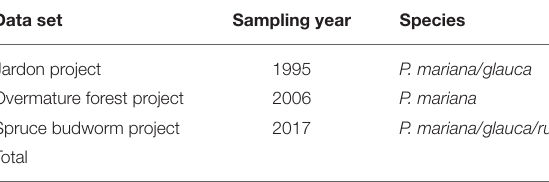
TABLE 1 | The dendrochronological data sets used in this study. Data